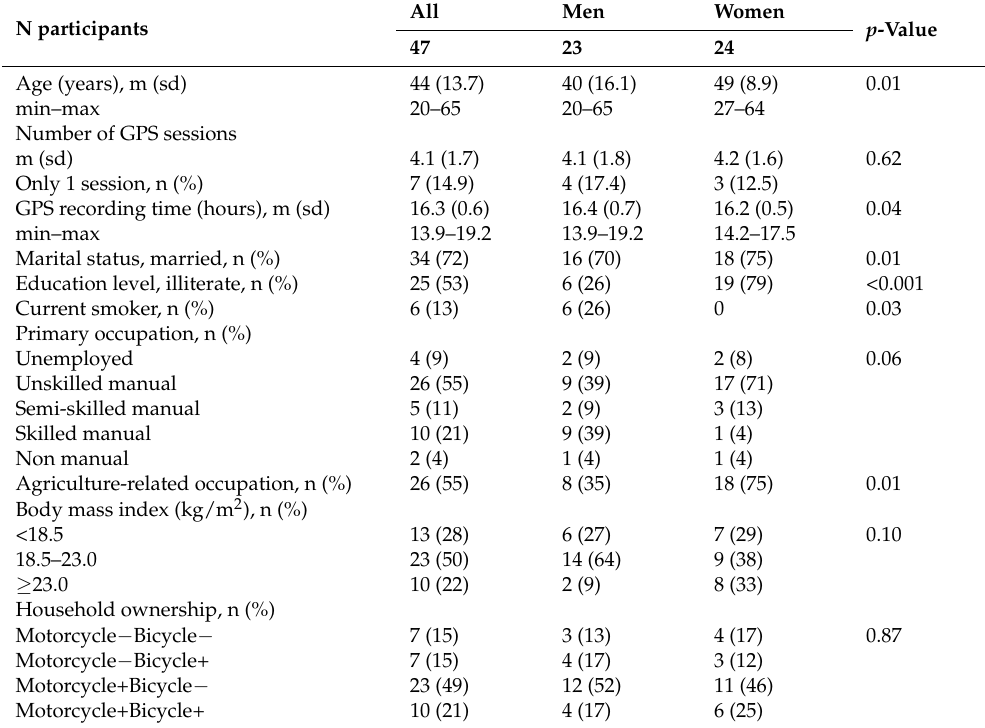
Table 2. Characteristics of the study